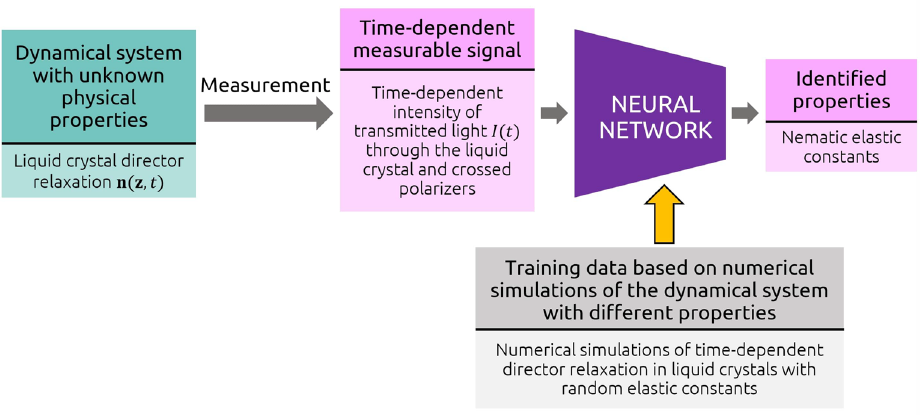
Figure 1. Graphical overview of the method for the identification of unknown parameters of dynamical systems based on numerical simulations and artificial neural networks. In this study, such an approach was used to determine Frank nematic elastic constants from measured time-dependent intensities of transmitted light through liquid